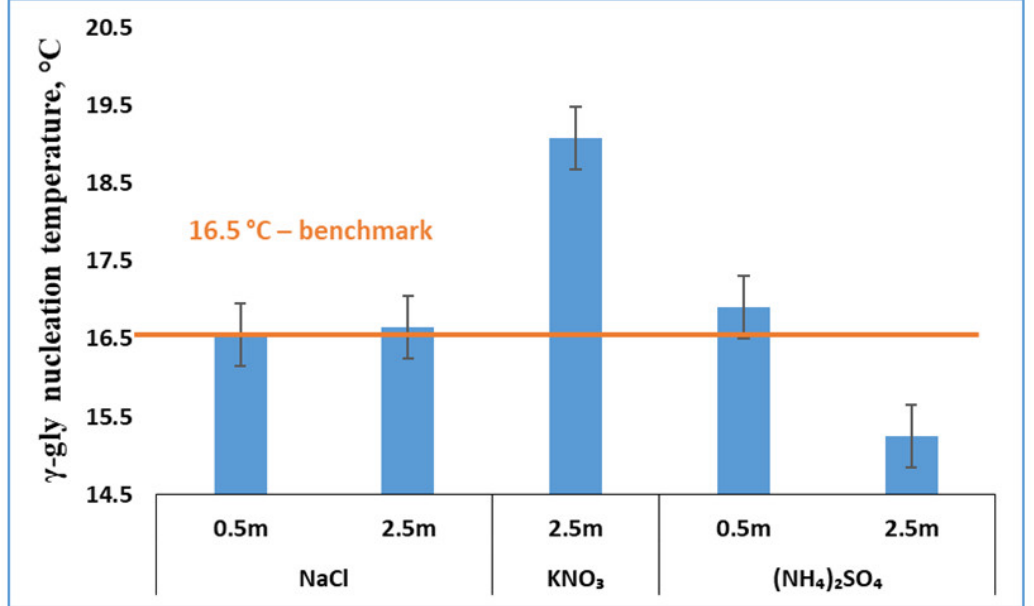
Figure 3. Effects of three salts on the nucleation temperature of γ-glycine (error bar = ±0.4 °C).